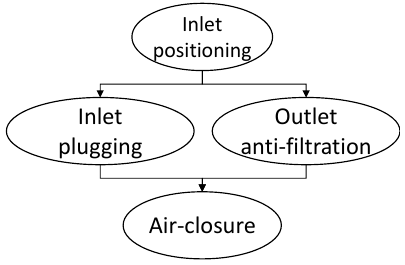
Figure 2. The plugging process of a dike leak.